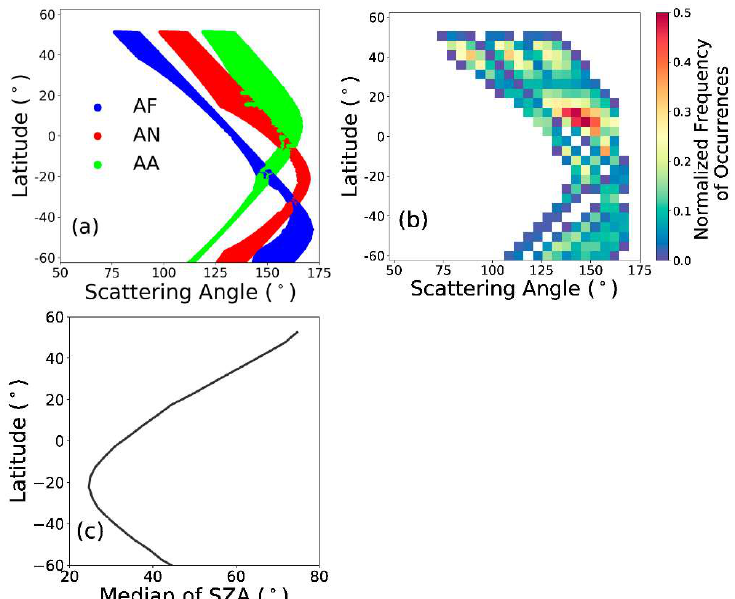
Figure 2. Multi-angle Imaging SpectroRadiometer (MISR) camera ( a ) names and ( b ) normalized frequency of occurrences as a function of scattering angle and latitude on the four December solstice days (2012–2015) from the MISR-MODIS fused datasets over ocean. ( c ) The median value of the solar zenith angle (SZA) as a function of latitude on the same dates.